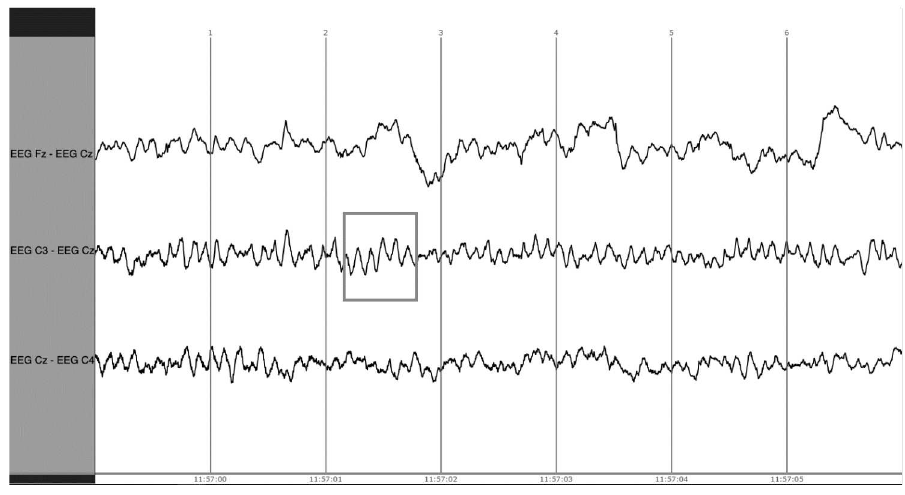
Figure 3. Excess Theta waves – sample 1